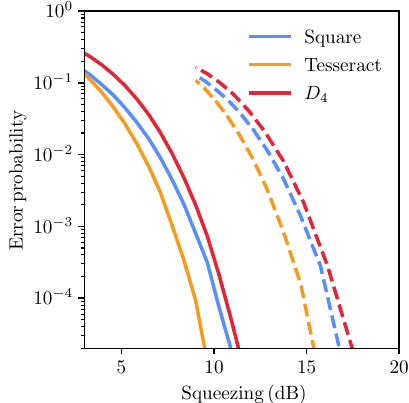
FIG. 7. Logical error probability for different GKP codes against the Gaussian translation error channel, with a translation noise standard deviation expressed in decibels. Full lines corre- spond to measurement performed with ideal ancilla GKP states, and dashed lines correspond to noisy